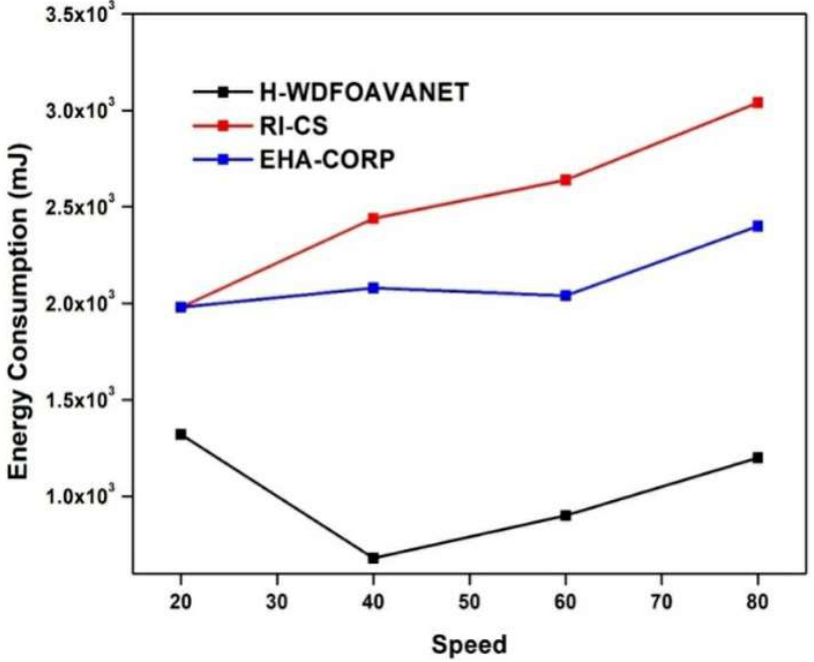
Figure 21. Plots of speed vs. energy consumption in the suggested approach and existing